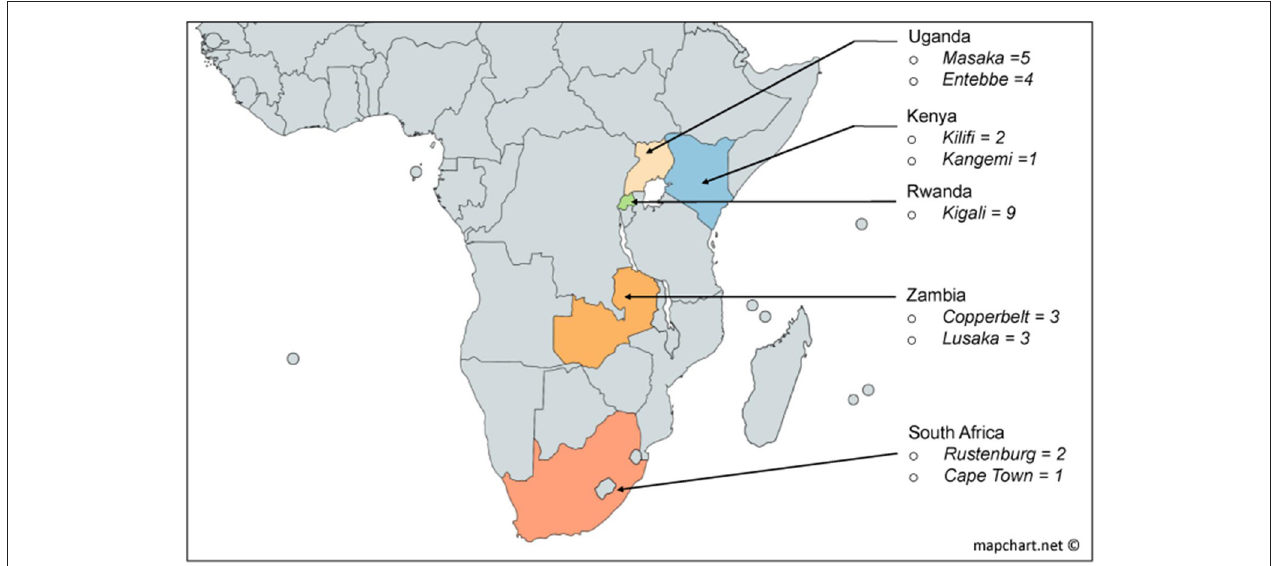
FIGURE 1 | Derivation by country of the 30 volunteers used in this study from the African incidence cohort [Protocol C